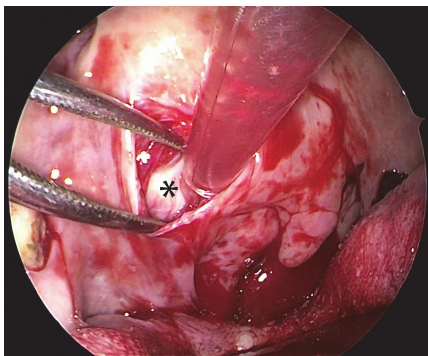
Figure 3: Endoscopic view showing the tumor ( ∗ ) being dissected out bluntly from the prestyloid space.